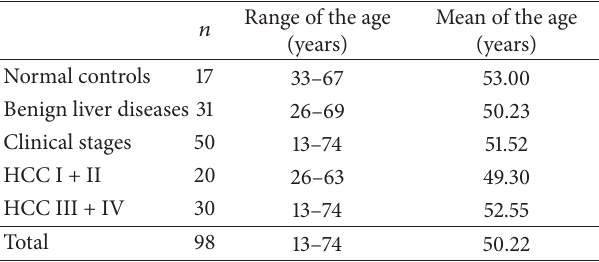
Table 4: Characteristics of 98 patients for serum